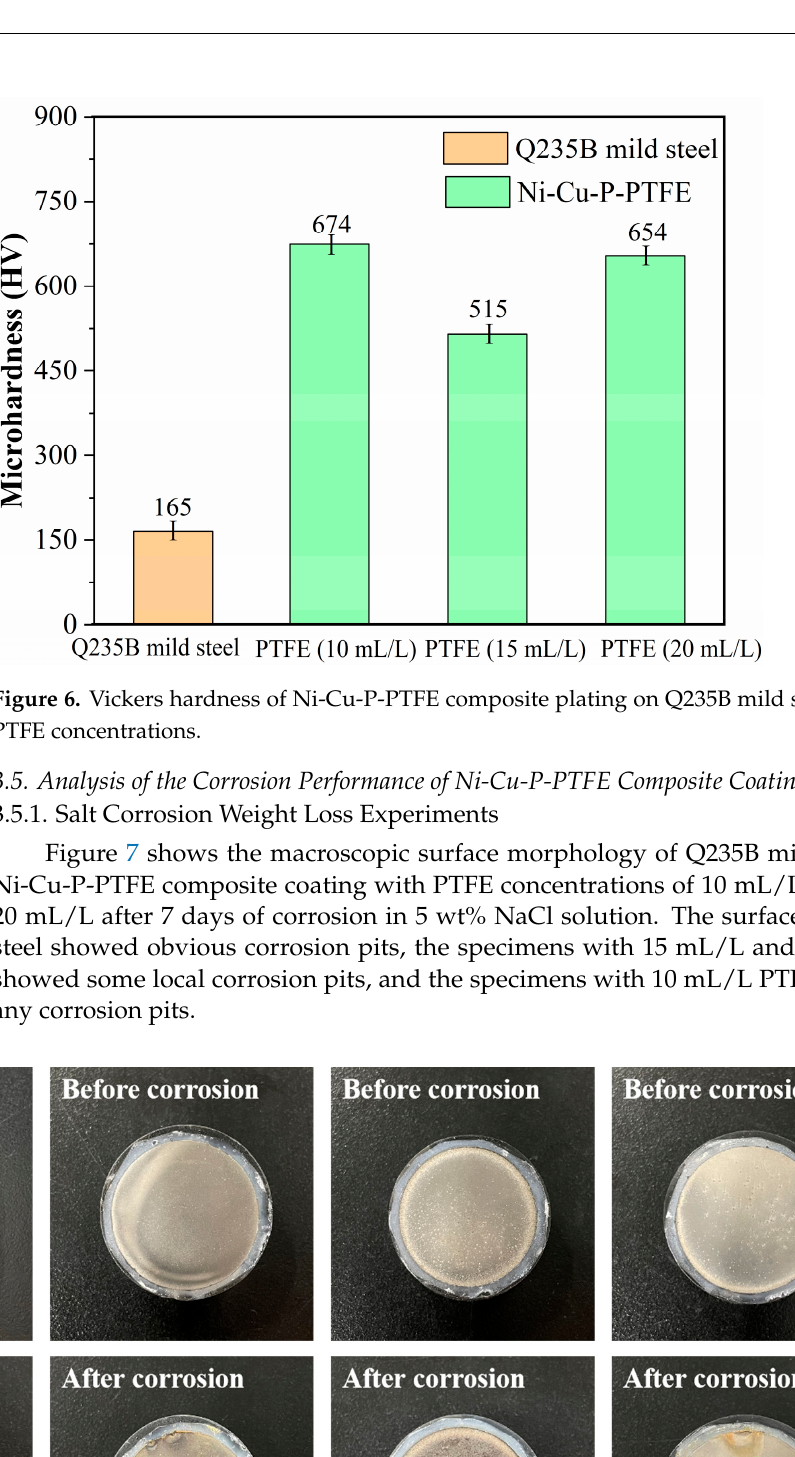
Figure 8. The corrosion rate of Q235B mild steel and Ni-Cu-P-PTFE composite coatings with different PTFE concentrations in 5 wt% NaCl solution. 3.5.2. Electrochemical Impedance Spectroscopy Analysis Figure 9 shows the electrochemical impedance spectroscopy (EIS) data of Q235B mild steel and Ni-Cu-P-PTFE composite coatings with three different PTFE concentrations in 3.5 wt% NaCl solution. It can be seen from the results of the impedance diagram that the impedance arc diameters of Ni-Cu-P-PTFE composite coatings with three different concentrations of PTFE were larger than those of Q235B mild steel. With the increase in PTFE concentration, the impedance arc diameters of the Ni-Cu-P-PTFE composite coatings showed a gradually decreasing trend. Generally, the larger the diameter of the impedance arc, the better the corrosion resistance of the material [36]. Obviously, the corrosion resistance of Ni-Cu-P-PTFE composite coatings with three different PTFE